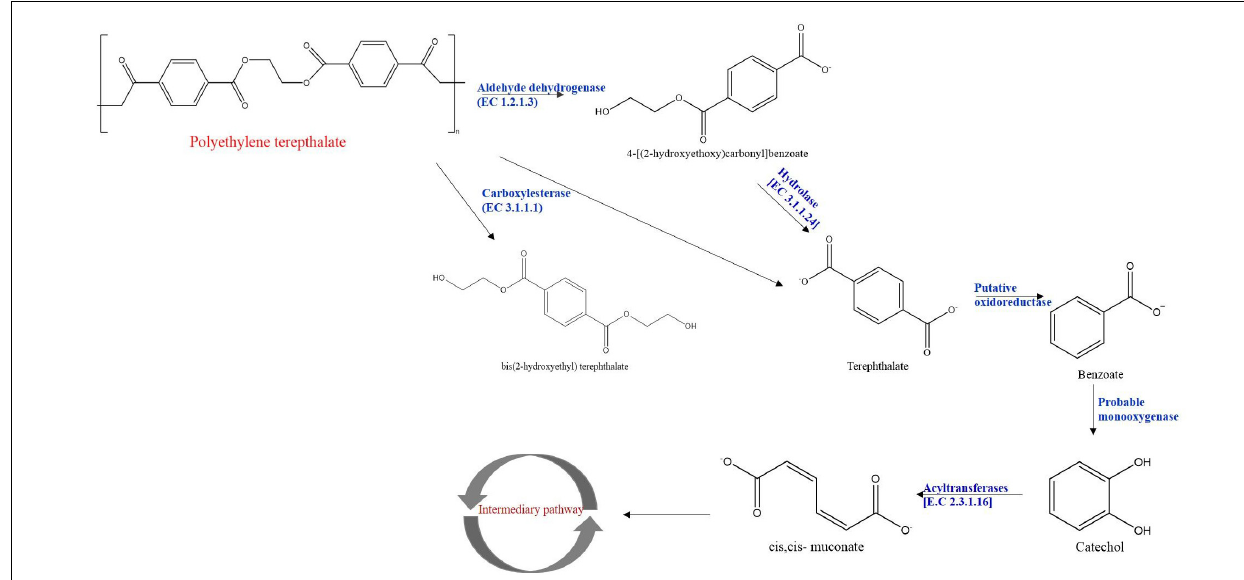
FIGURE 10 | Proposed PET metabolism by Bacillus species AIIW2.